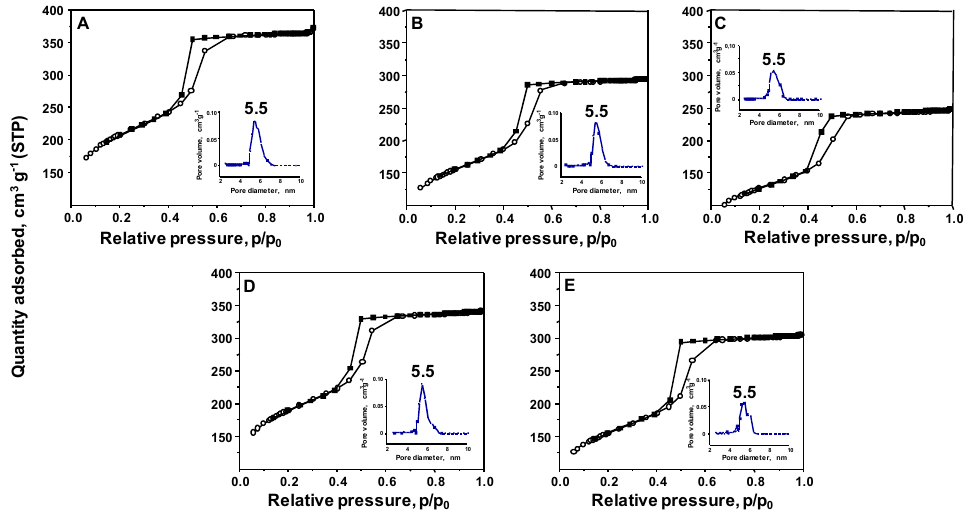
Figure 2. N 2 adsorption/desorption isotherms and pore size distribution of materials obtained. ( A ) SBA-15, ( B ) V M /SBA-15, ( C ) TPS/V M /SBA-15, ( D ) V S /SBA-15, ( E ) TPS/V S /SBA-15